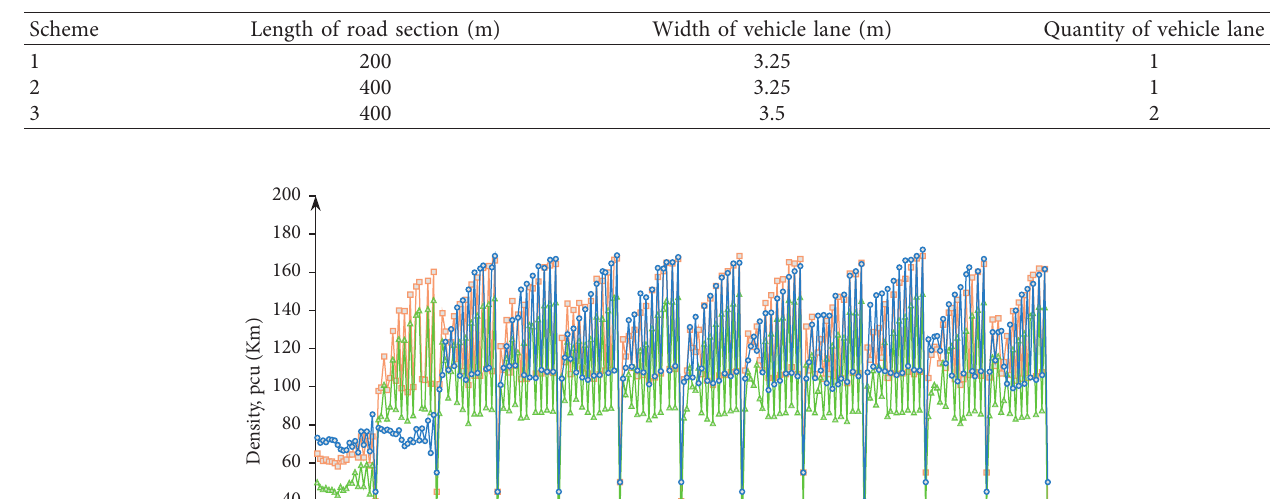
Table 1: Simulation scheme setting.